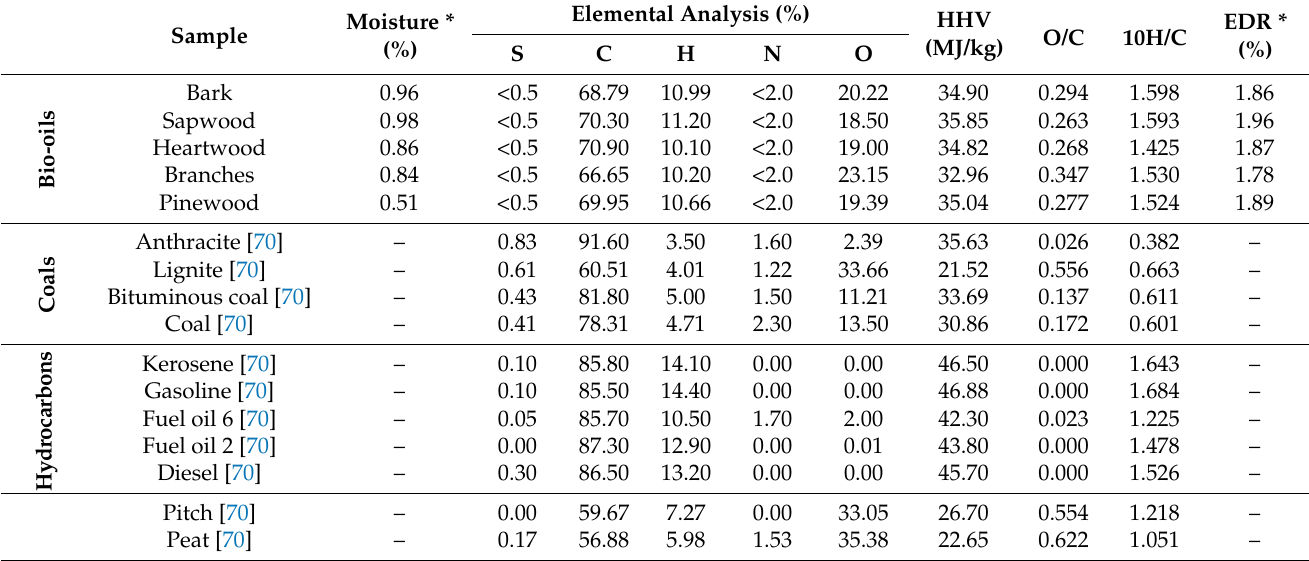
Table 3. Moisture content, elemental analysis, and HHV of bio-oil produced from different types of biomasses after 60 min. Sample